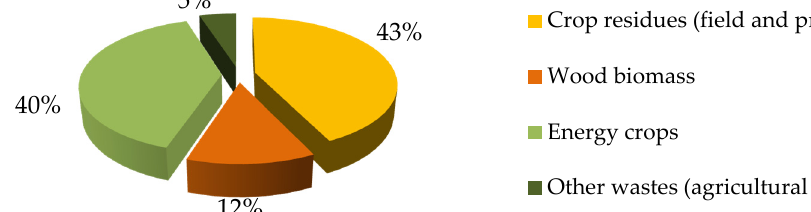
Figure 1. Economic potential of energy generation from biomass in Ukraine by inputs (based on 2017 data). Source: own aggregation based on Bioenergy Association of Ukraine estimations [4].